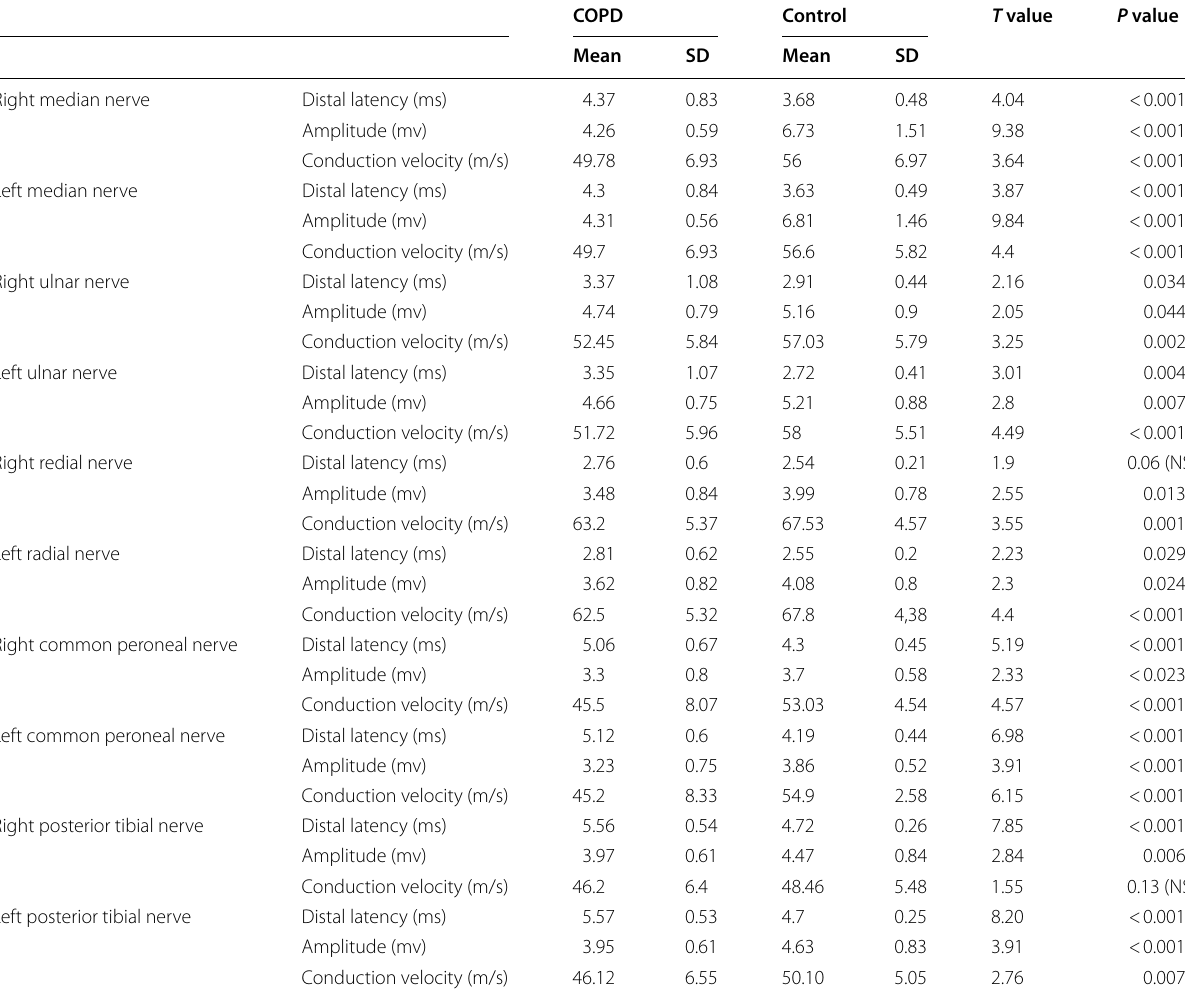
ms millisecond, mv